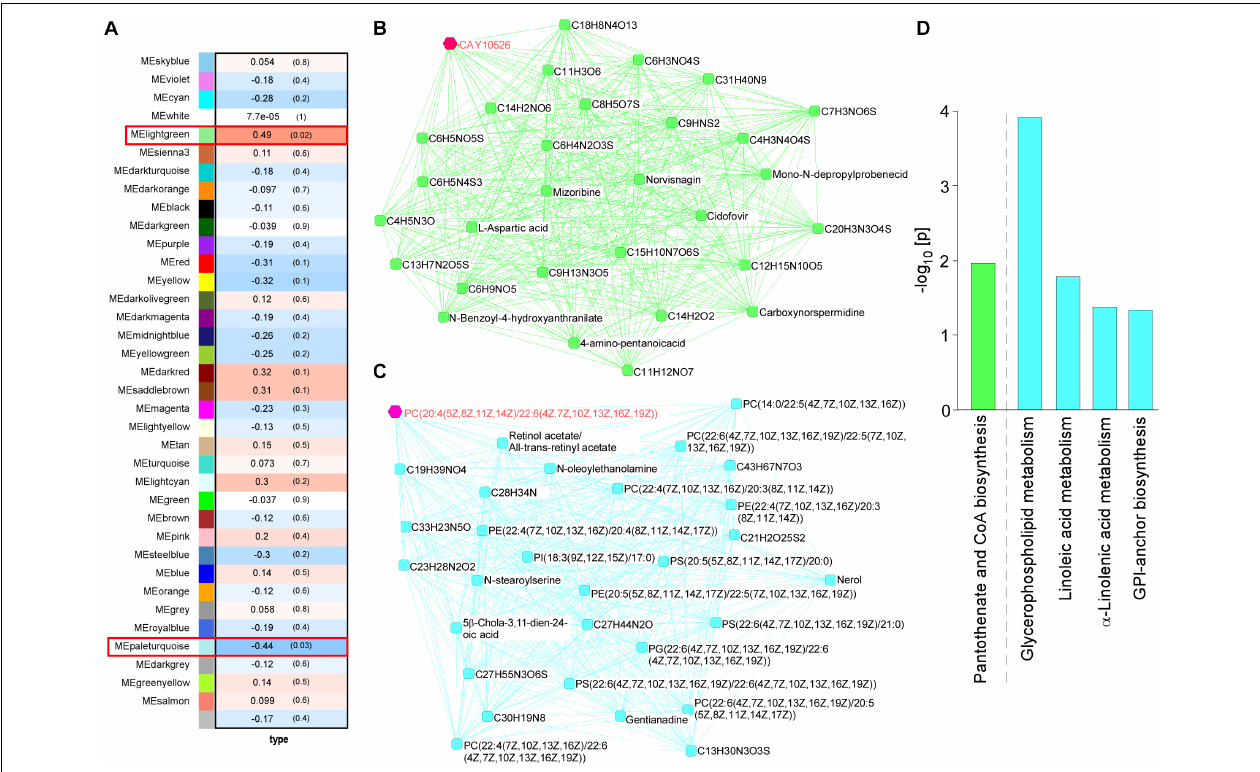
FIGURE 2 | Impact of ABCA7 haplodeficiency and peripheral LPS stimulation on mouse cortical metabolomes. (A) The correlation between metabolite module eigengenes and the four groups of mice: (1) control with LPS administration, (2) Abca7 ± with LPS administration, (3) control with LPS administration, and (4) Abca7 ± with LPS administration. Each module is represented with a unique color. The module traits were correlated with the four groups of mice (1–4). The corresponding correlations and P -values are displayed in each module. (B,C) The interactions of top 30 hub metabolites within the lightgreen (B) and paleturquoise (C) modules were visualized. (D) Pathway analysis of metabolites using the KEGG database. Pathways in the lightgreen (B) and paleturquoise (C) modules are shown (raw p -value < 0.05).